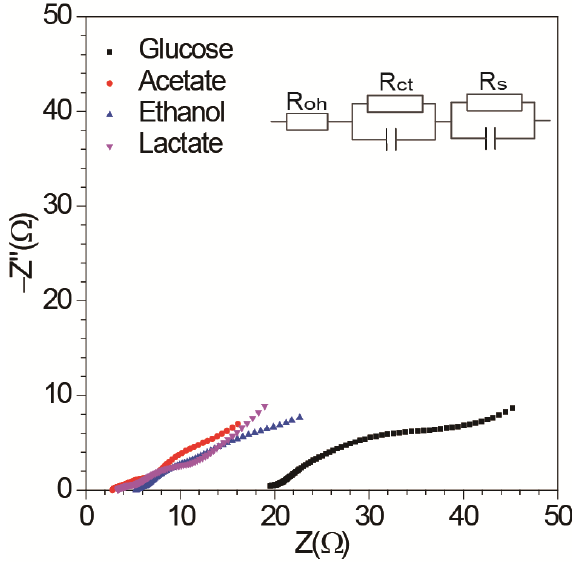
Figure 3. Electrochemical impedance spectroscopy (EIS) analysis of the MFCs containing the bioelectroactive biofilms enriched with different energy substrates.